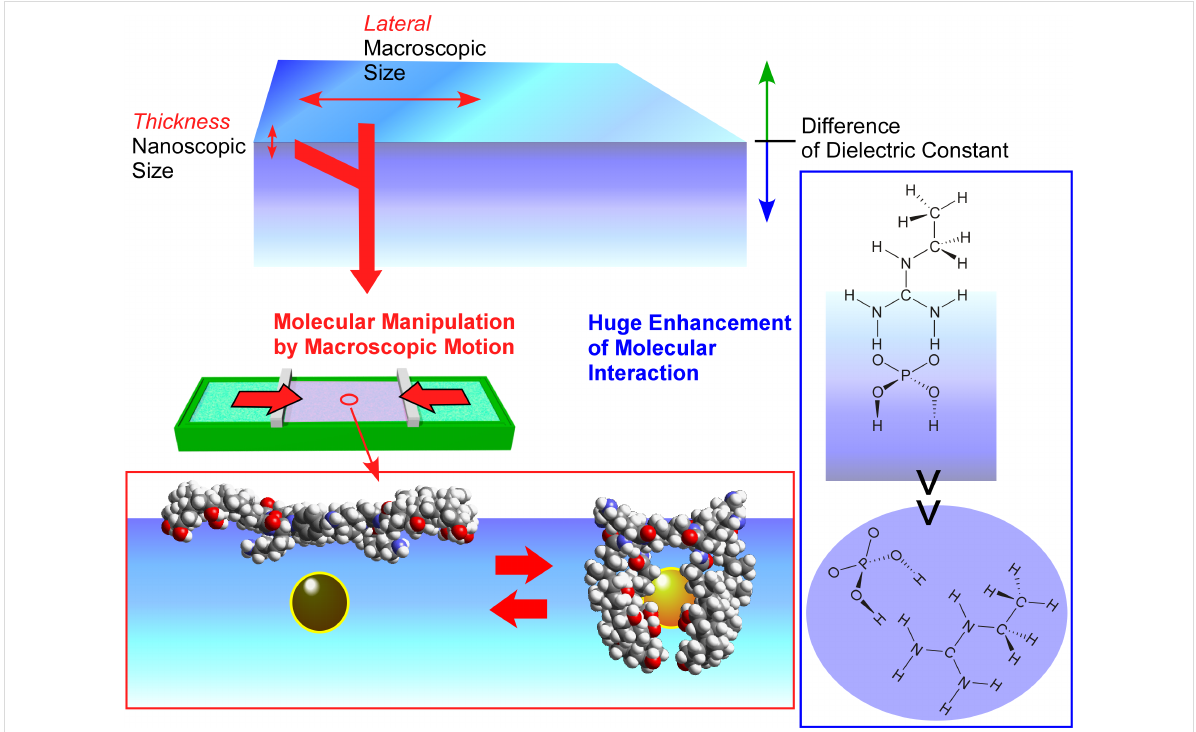
Figure 8: Mode of molecular recognition and sensing: (A) one most stable state between guest and host; (B) switching molecular binding by external stimuli; (c) tuning of receptor structures through continuously shifting molecular conformations for required demands. Adapted with permission from [52] copyright 2016, Springer